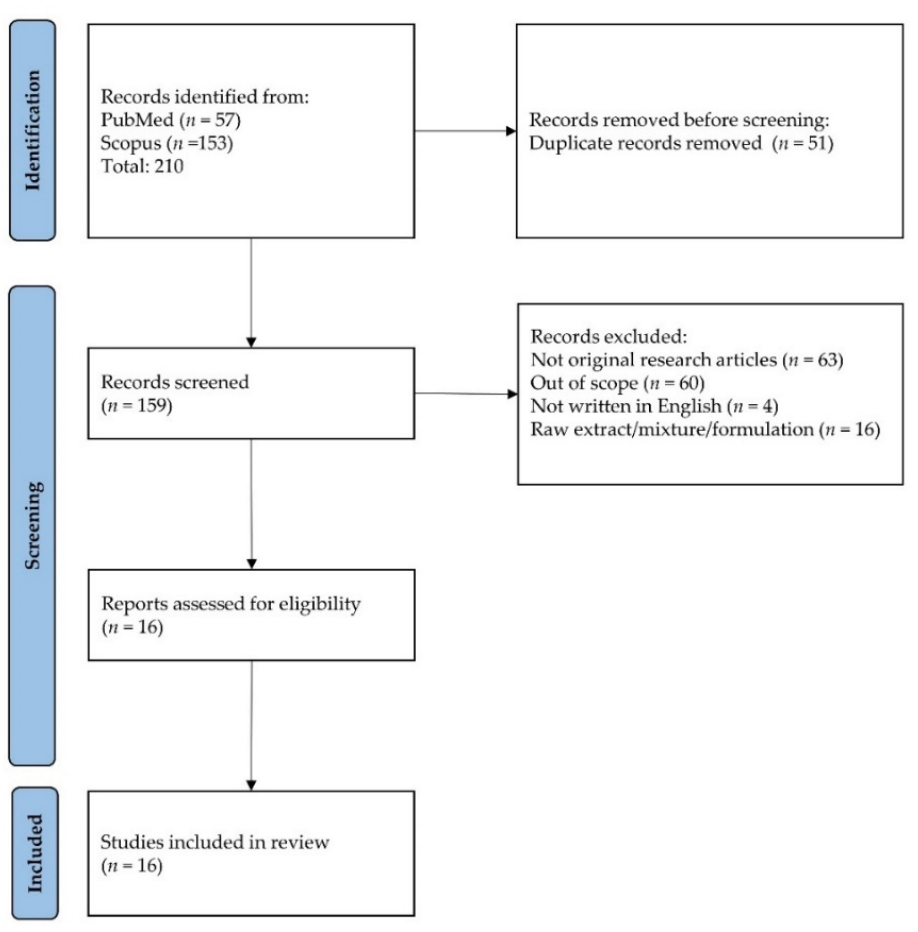
Figure 2. Flowchart showing selection of articles.